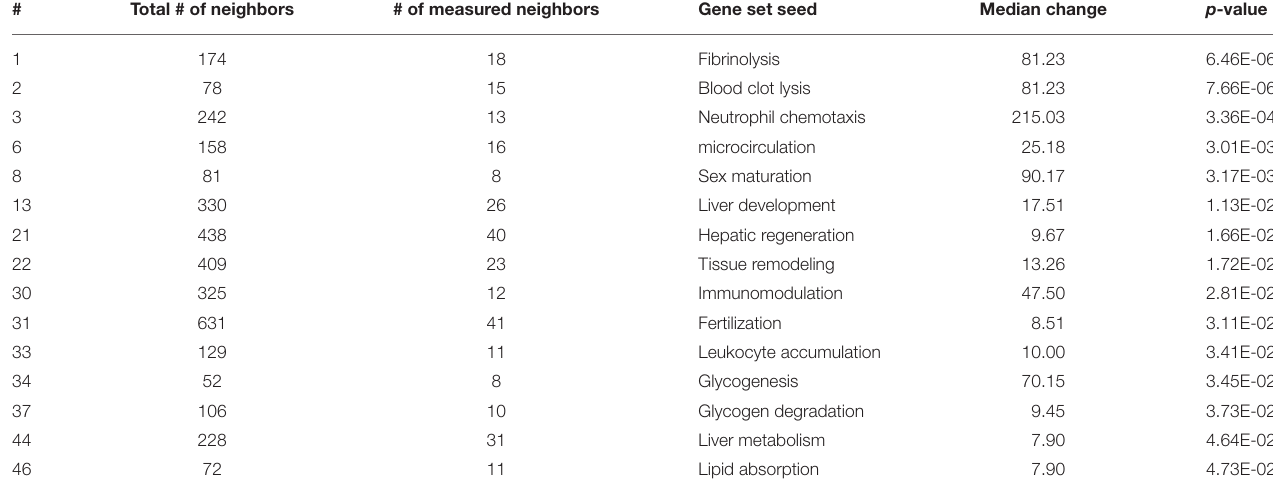
TABLE 3 | Selected subnetwork enrichment pathways for the